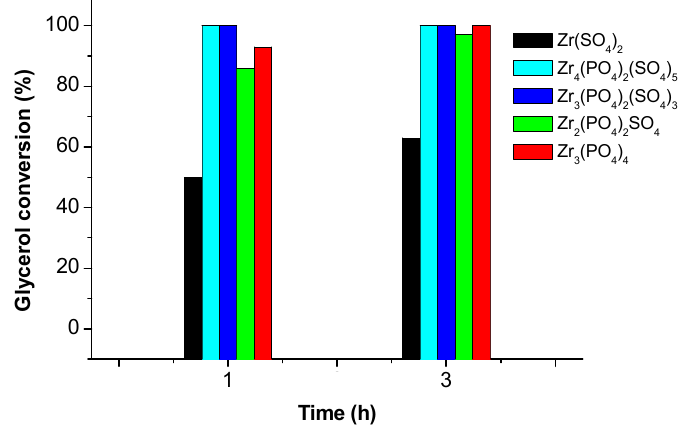
Figure 7. Conversion of glycerol over different Zr Phosphate-Sulphate catalysts.